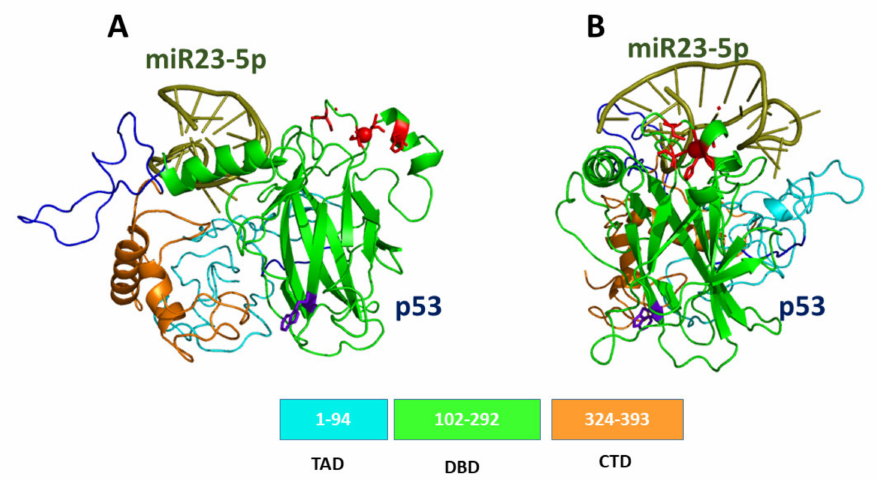
Figure 9. Front ( A ) and lateral ( B ) views of the graphical representation for the best model for the complex between p53 and miR23-5p (olive). The initial structure of p53 was taken from the model shown in Figure 1B, while that of miR23-5p is the model in Figure